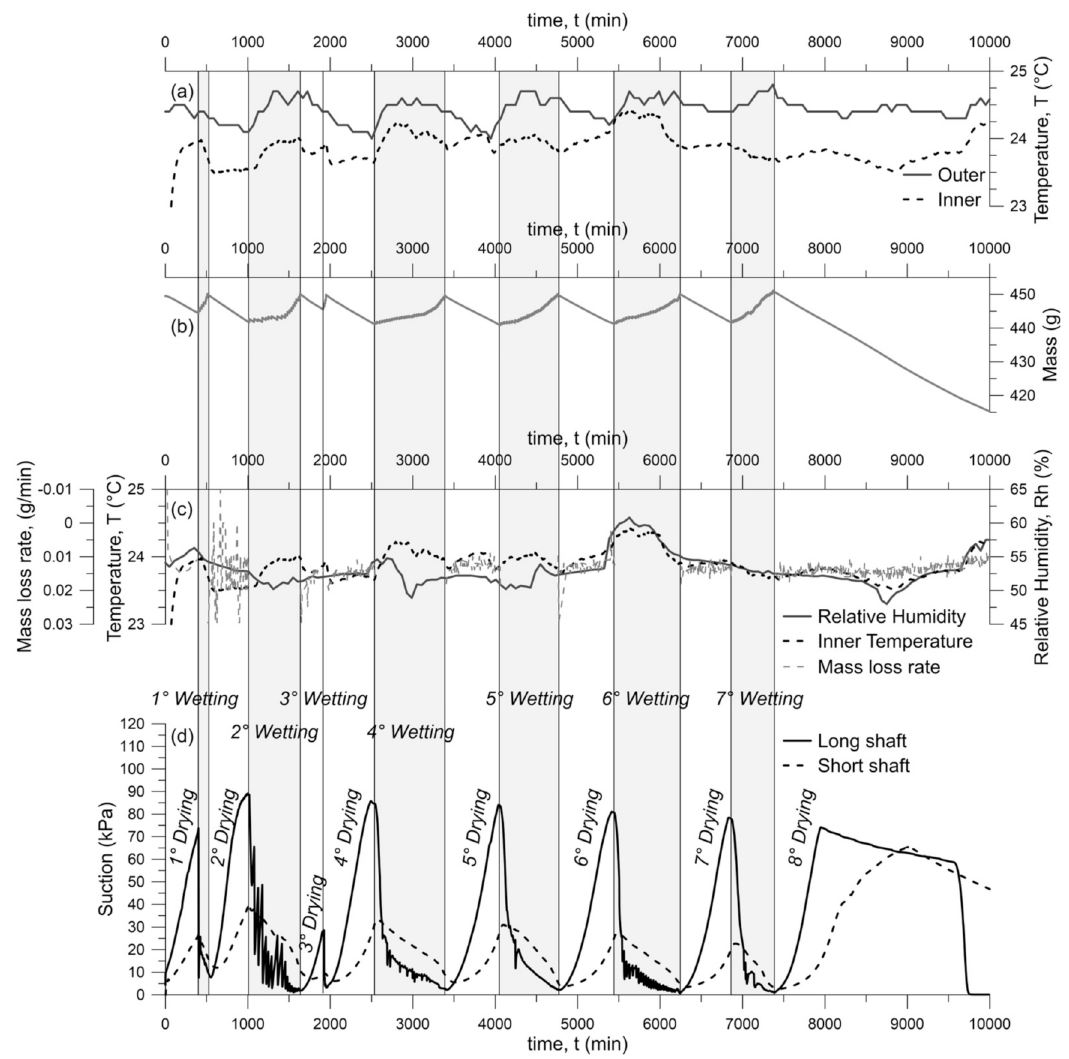
Figure 7. Data logged during drying and wetting cycles on a sample of the dyke silty material: ( a ) inner and outer temperature, ( b ) temperature, Rh and mass loss rate, ( c ) net sample mass and ( d ) suction readings as a function of